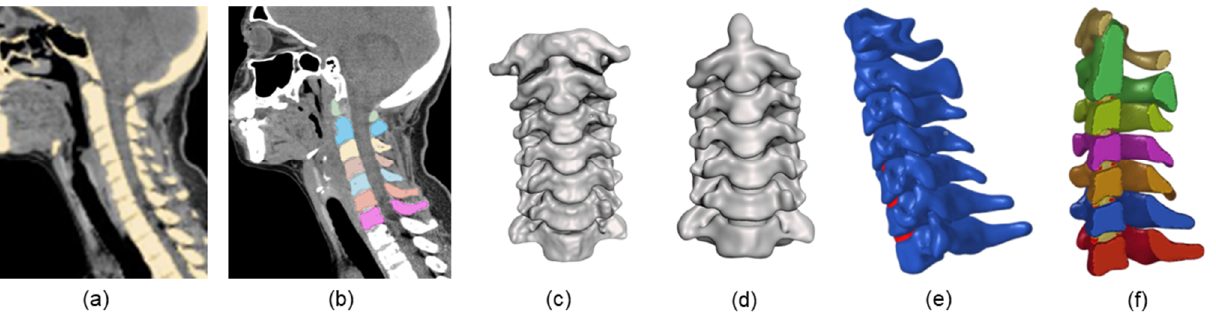
Figure 1. Methodology used to model the cervical spine: ( a ) Geometrical acquisition from CT scans; ( b ) Segmentation of the desired vertebrae; ( c ) Conversion of the model into an STL file; ( d ) Creation of the intervertebral disc geometry and smoothing; ( e ) Mesh generation; ( f ) Separation of the different materials on the components created.